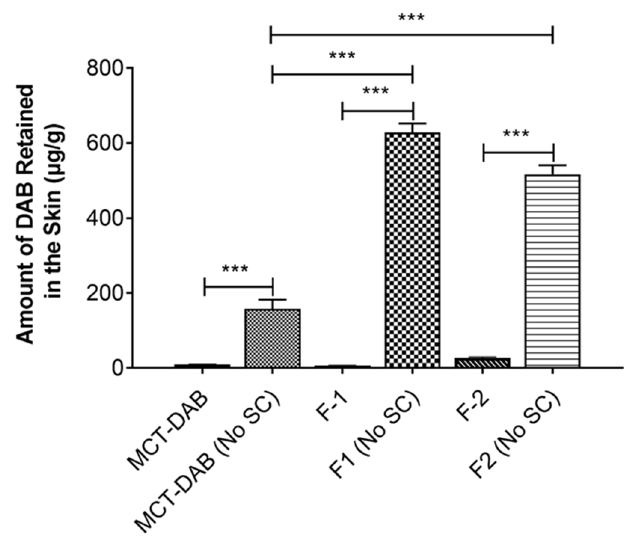
Figure 4. Effect of stratum corneum tape-stripping on the skin retention of DAB in human cadaver skin. All data are expressed as mean ± standard error, n = 3. *** p < 0.001 as compared with MCT-DAB.